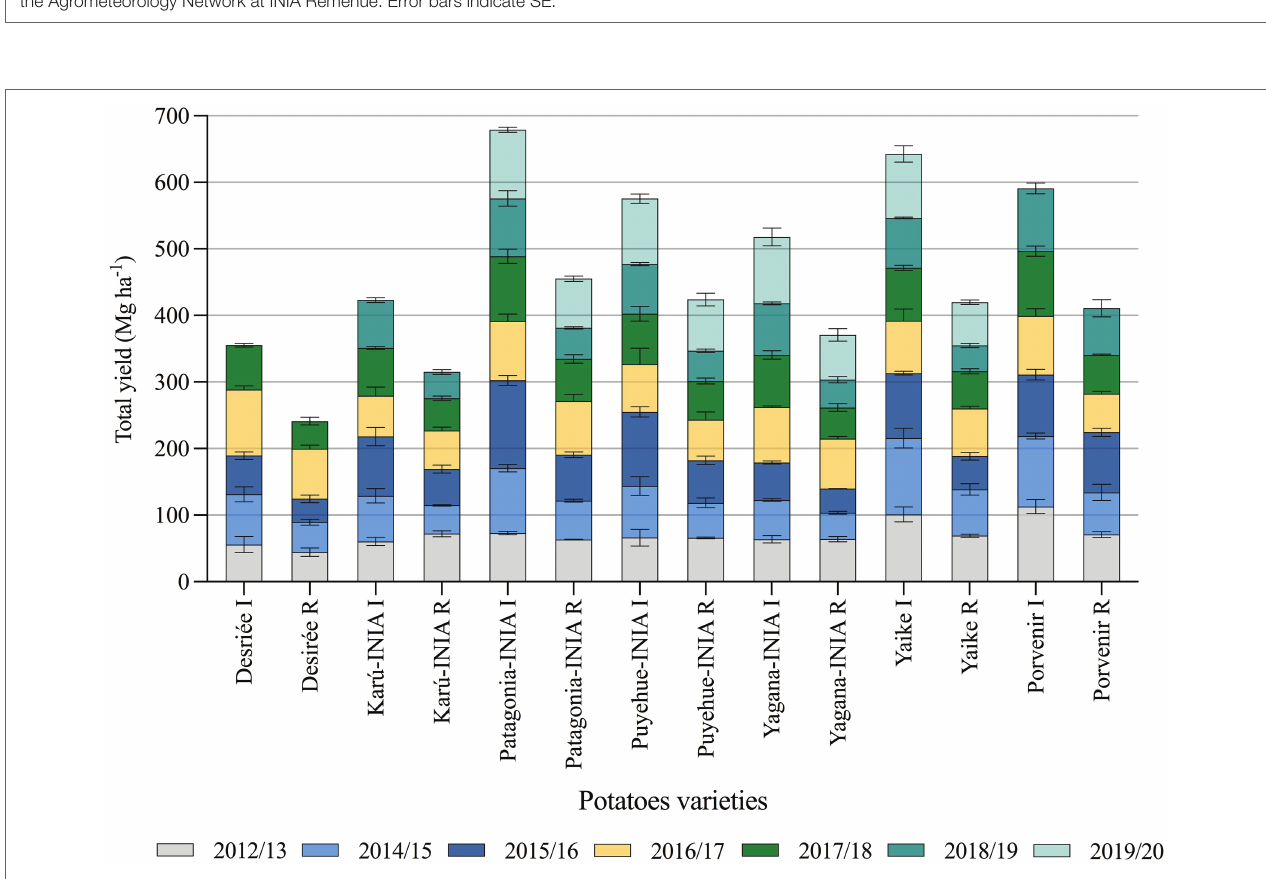
FIGURE 3 | Mean monthly rainfall, temperature, and solar radiation distribution during development stage in potato (2012–13 to 2019–20). Data were provided by the Agrometeorology Network at INIA Remehue. Error bars indicate SE.